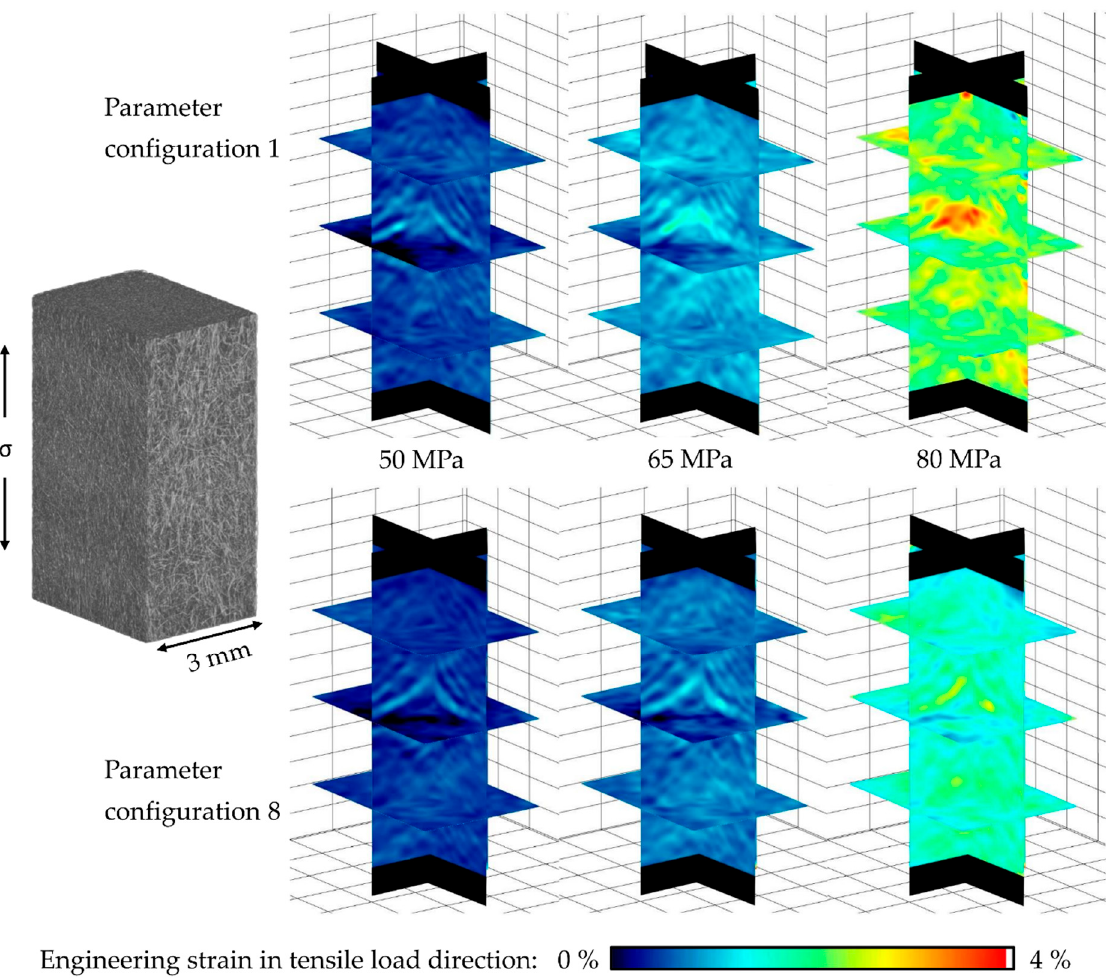
Figure 16. Strain distribution in tensile stress direction at selected σ max of 50, 65 and 80 MPa for parameter configurations 1 and 8.